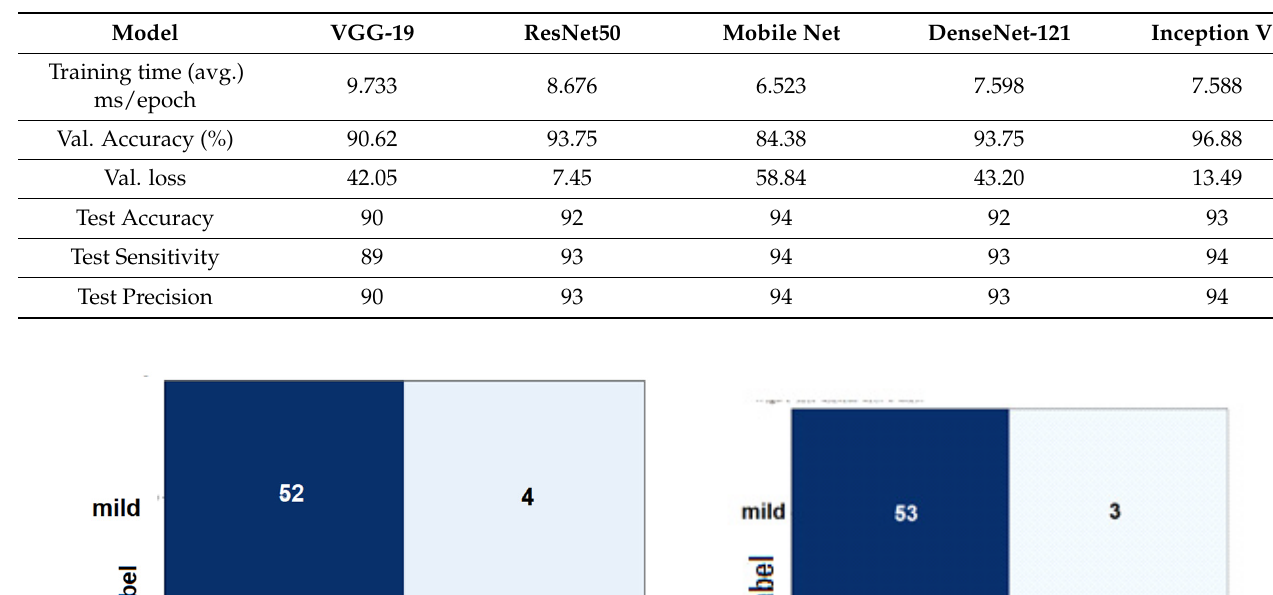
Table 4. Comparison of pre-trained models for 4 Class Classification.